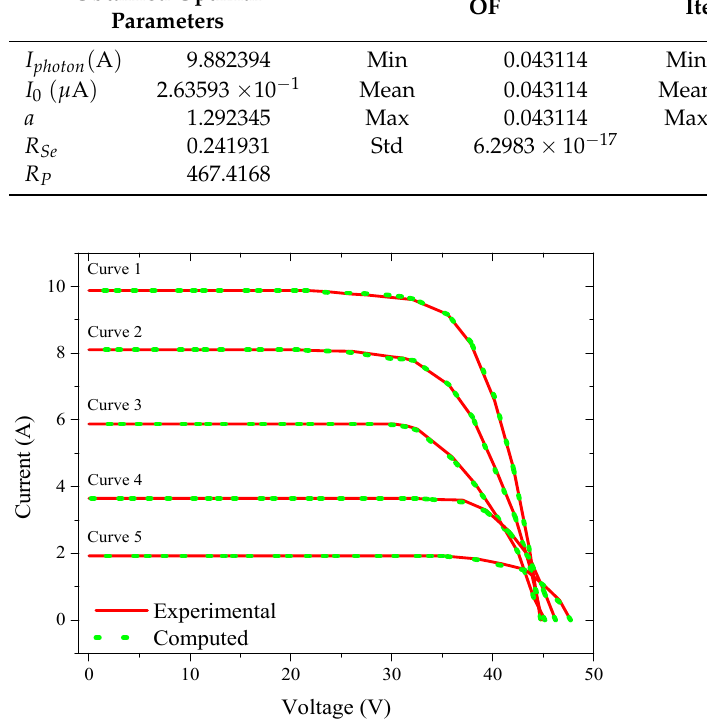
Figure 13. I–V curves of DDM, JKM330P-72 PV module for all respective curves.